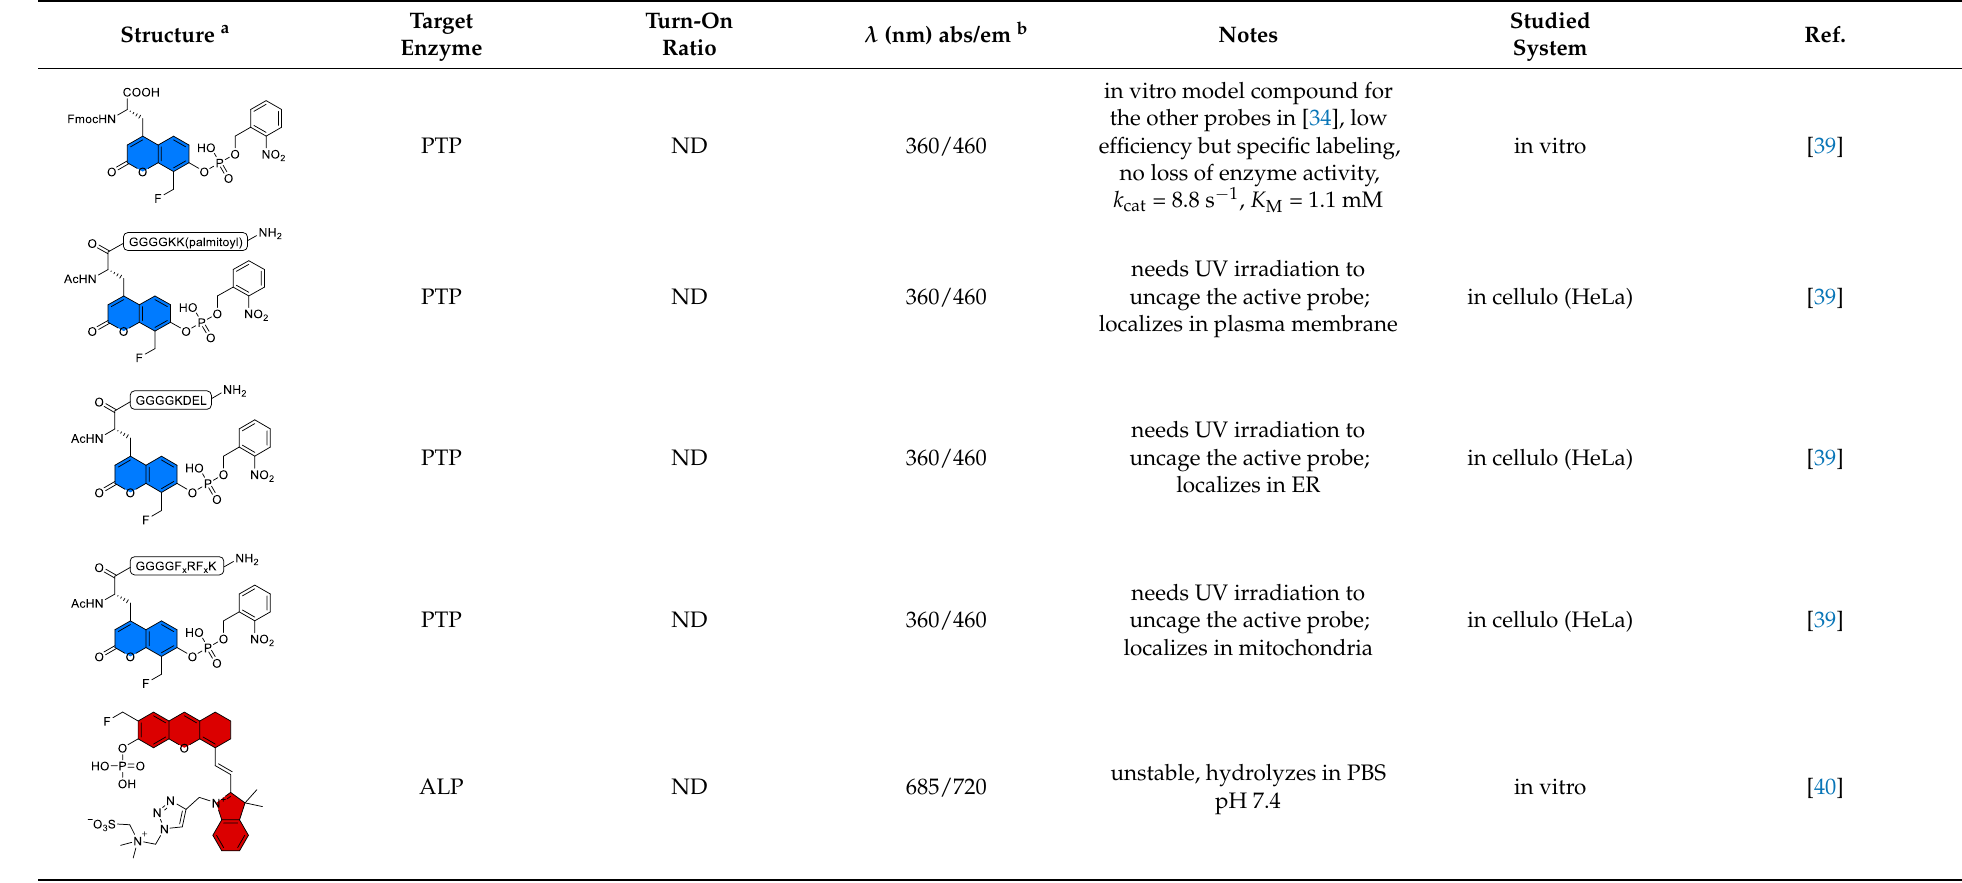
Table 3. Fluorogenic activity-based probes for different phosphatases.